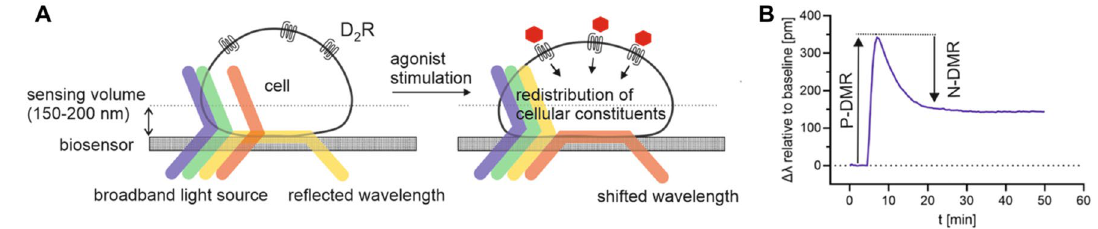
Figure 1. Schematic illustration of the DMR detection principle (adapted from Schröder et al. 31 ). ( A ) Cells are grown in microplates that contain a resonant waveguide grating biosensor within the bottom of each well. The biosensor is illuminated by a broadband light source and the wavelength that is in resonance with the system is propagated and reflected. The resonance wavelength is a function of the refractive index near the surface of the biosensor. Stimulation of the cells can lead to a dynamic mass redistribution (DMR) of cellular constituents and subsequently a change in refractive index. This leads to a shift of the resonant wavelength in the pm range (Δλ), representing the readout of the DMR assay. ( B ) DMR that increases the optical density in proximity to the sensor surface results in a positive signal (P-DMR), whereas a decrease in optical density results in a negative signal (N-DMR), relative to the baseline 31